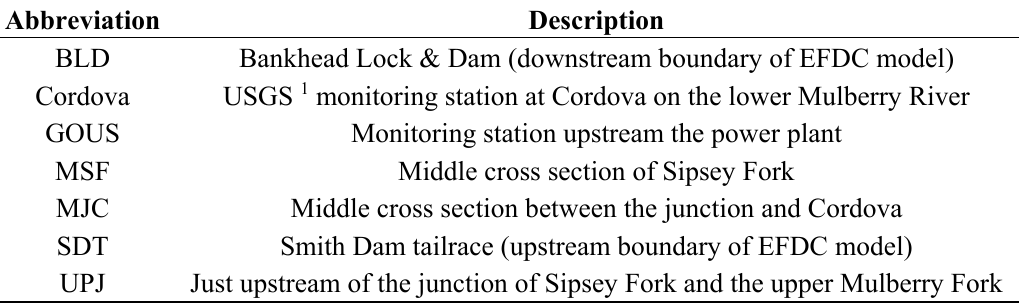
Figure 1. ( a ) Geographic location of the study area—Bankhead river-reservoir system (BRRS); ( b ) Longitudinal bottom elevation along the centerline of BRRS and water surface elevation after a large release from the Smith Dam tailrace (SDT) to GOUS; ( c ) Color contours of the bottom elevation showing Sipsey Fork, the lower Mulberry Fork, and Black Warrior River as the model simulation domain; two monitoring stations (Cordova and GOUS); model upstream and downstream boundary locations: Smith Dam tailrace (SDT) and Bankhead Lock & Dam (BLD); three cross sections for reporting simulation results (MSF, UPJ and MJC). Table 1. Abbreviations and descriptions of cross-sectional locations used in the study (Figure